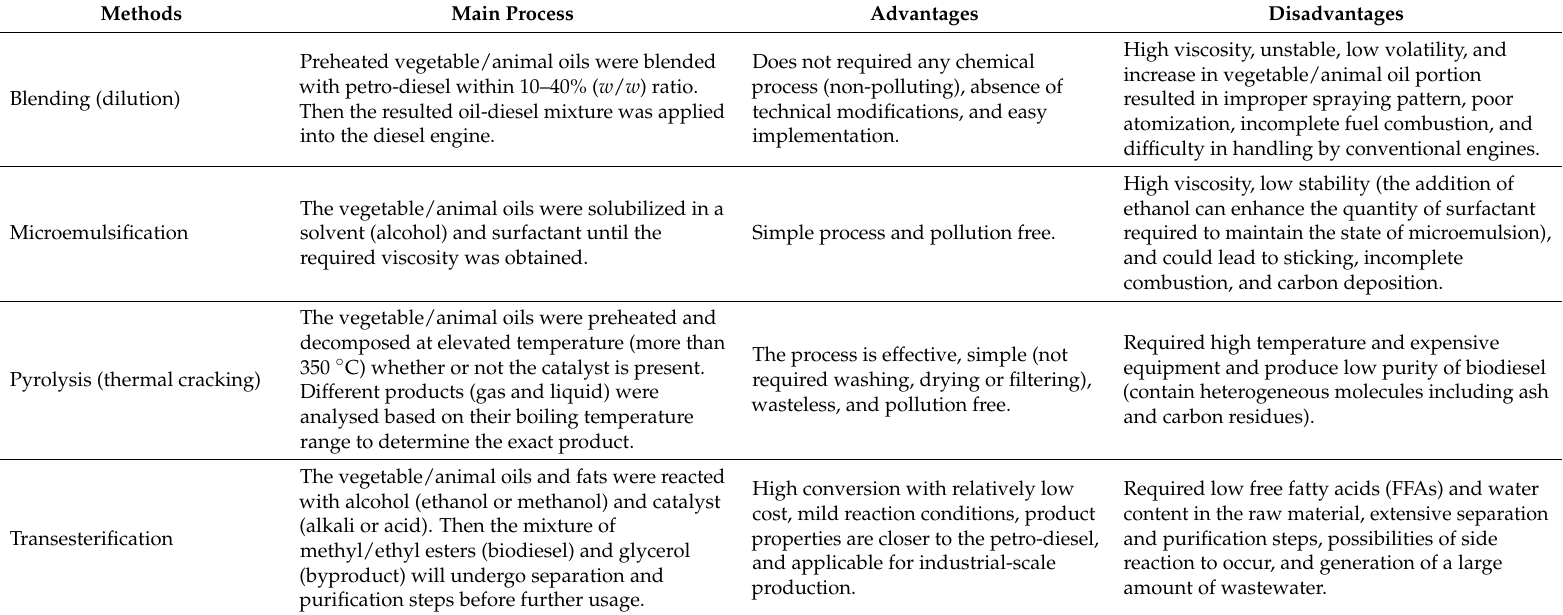
Table 1. Preparation and production of biodiesel using different methods